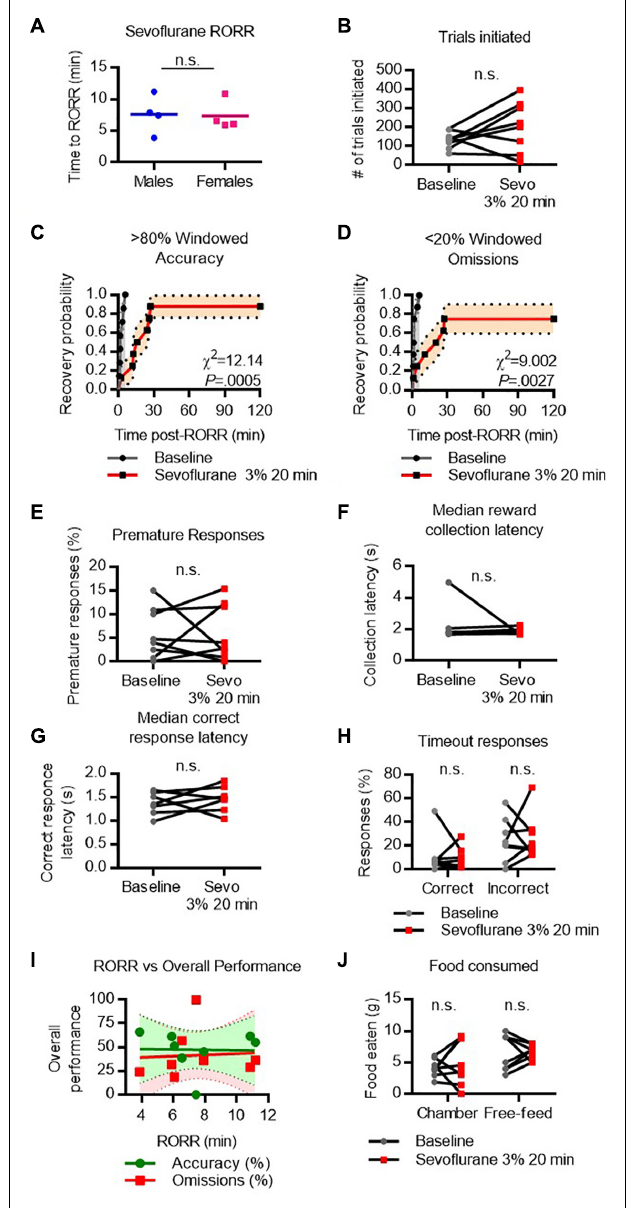
FIGURE 4 | Performance on the 5-CSRTT following sevoflurane. (A) Return of righting reflex (RORR) following 20 min of 3% sevoflurane in male and female rats. (B) Total number of 5-CSRTT trials initiated at baseline and following sevoflurane anesthesia. (C,D) Probability of achieving > 80% windowed accuracy (C) and < 20% windowed omissions (D) at baseline and following sevoflurane by the indicated time. (E,H) Difference in premature responses (E) , reward collection latency (F) , correct response latency (G) , and timeout responses to correct and incorrect windows (H) at baseline and following sevoflurane. (I) RORR latency vs. overall accuracy (green) and omission (red) performance following sevoflurane anesthesia. Regression slope (solid line) and 95% confidence interval (dashed lines) indicated. (J) Total weight of food eaten in the chamber during the task and following the task during the free-feeding period at baseline and following sevoflurane. n.s., not significant; N =